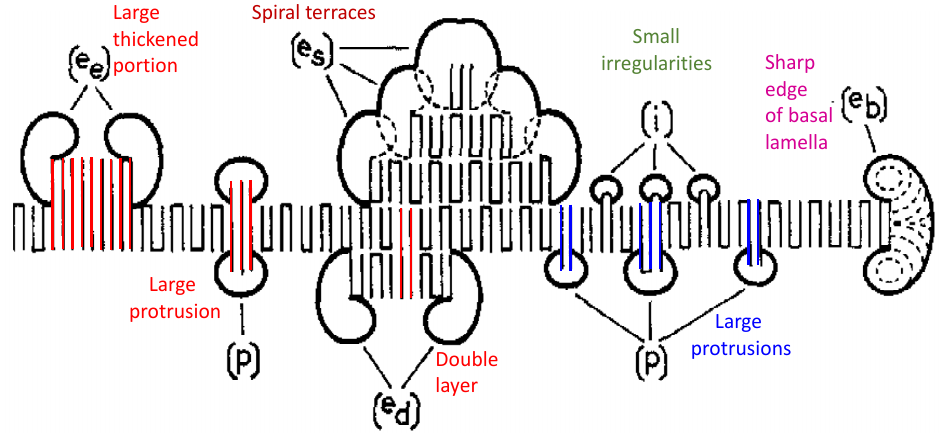
Figure 3. Schematic cross-section of a self-decorated poly(ethylene oxide) (PEO) crystal lamella, showing the various decorating sites, which can be encountered on PEO single crystals grown from the melt (note that the thickness of the basal lamella is about 100 times enlarged with respect to the size of the decorating units). Adapted by permission from ref. [17] Copyright 1972, Springer.